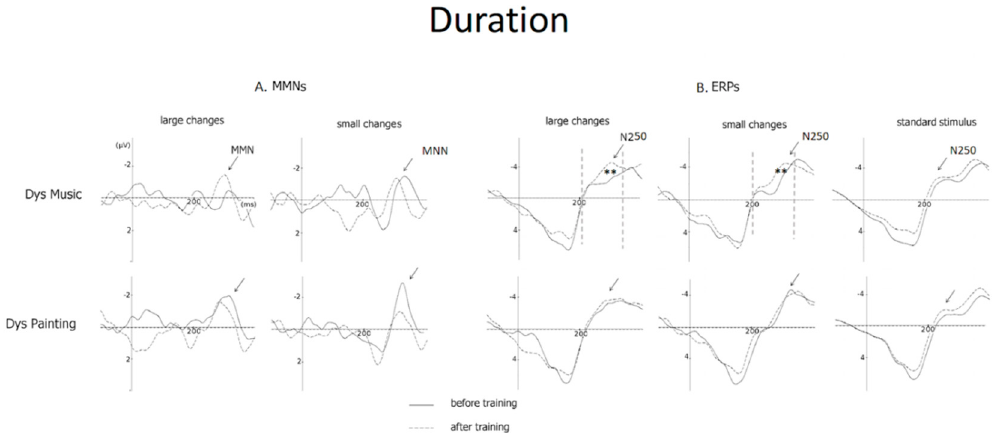
Figure 5. ( A ) Mismatch Negativities (MMNs) and ( B ) ERPs at Fz to large and small duration changes as well as for standard stimuli (for ERPs) before training (solid line) and after training (dashed line) for children with dyslexia in the music group (Dys Mus) and in the painting group (DysPaint). Table 4. Mean N250 amplitude (in microvolts) at Frontal and Central sites for children with DD trained with music (DysMus) or with painting (DysPaint) before and after training, for large and small duration deviant stimuli. Frontal Central Before After Before After Large Dev. − 1.96 − 2.99 DysMus Small Dev. Large Dev. DysPaint Small Dev.